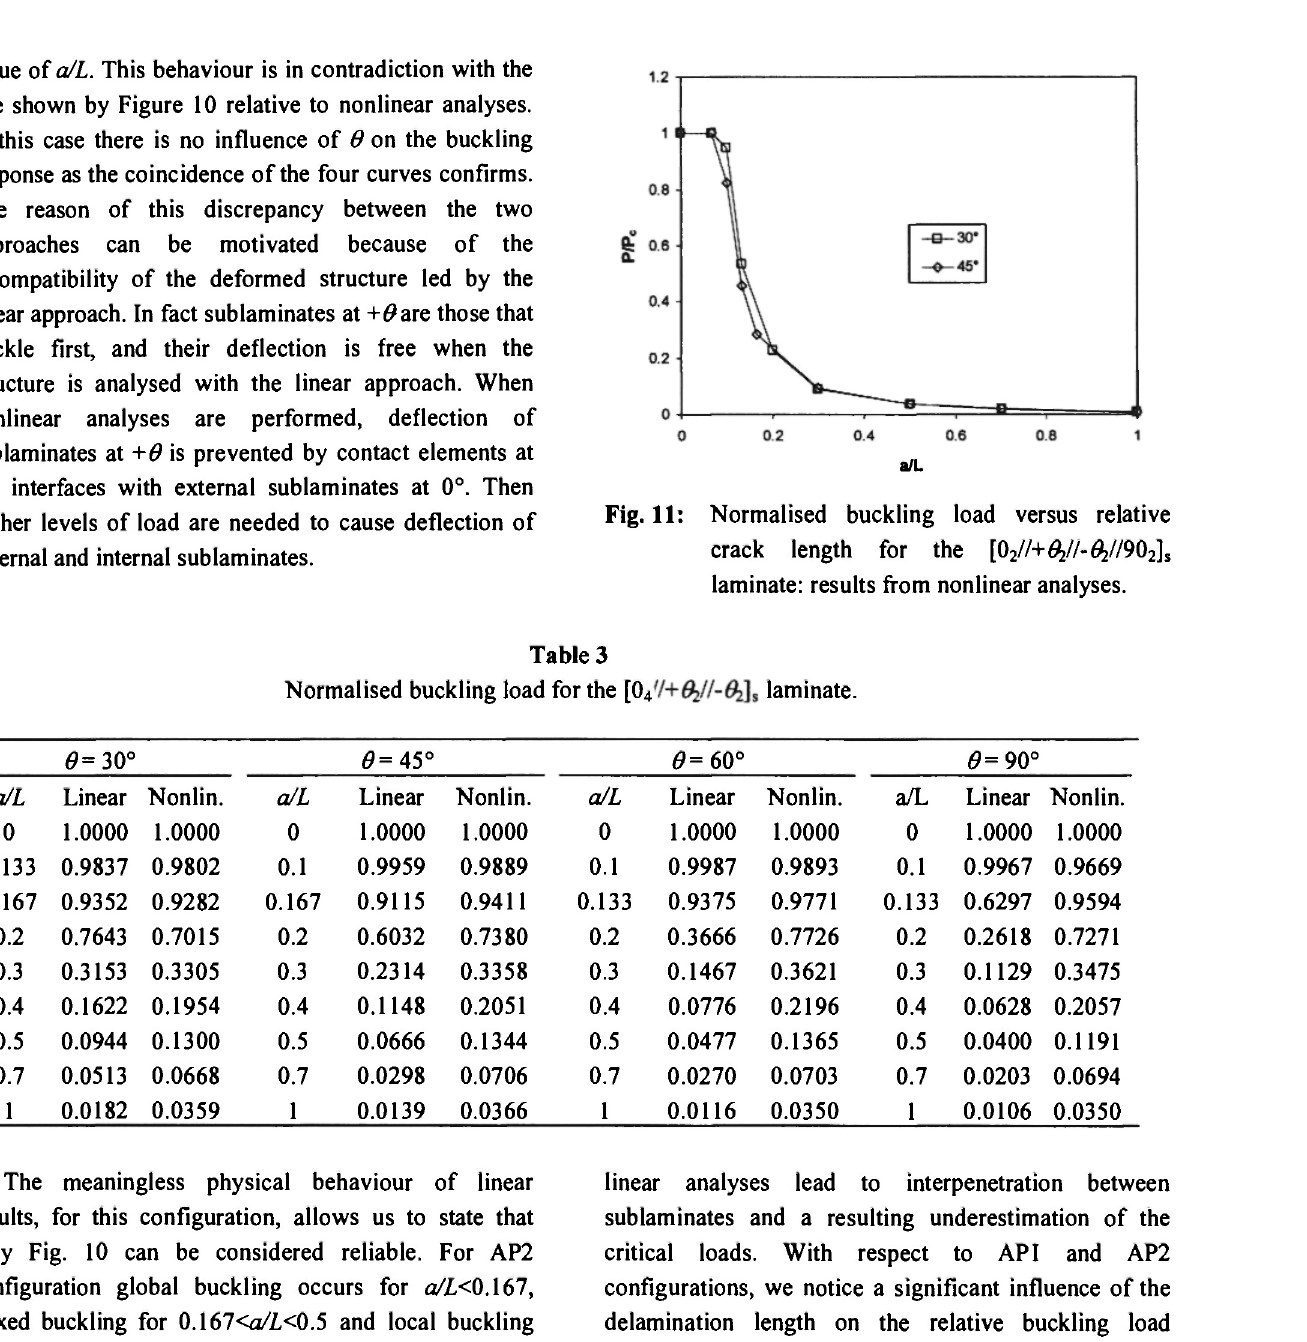
Fig. 11: Normalised buckling load versus relative crack length for the [0 2 //+<%//-<%//90 2 ] s laminate: results from nonlinear analyses.